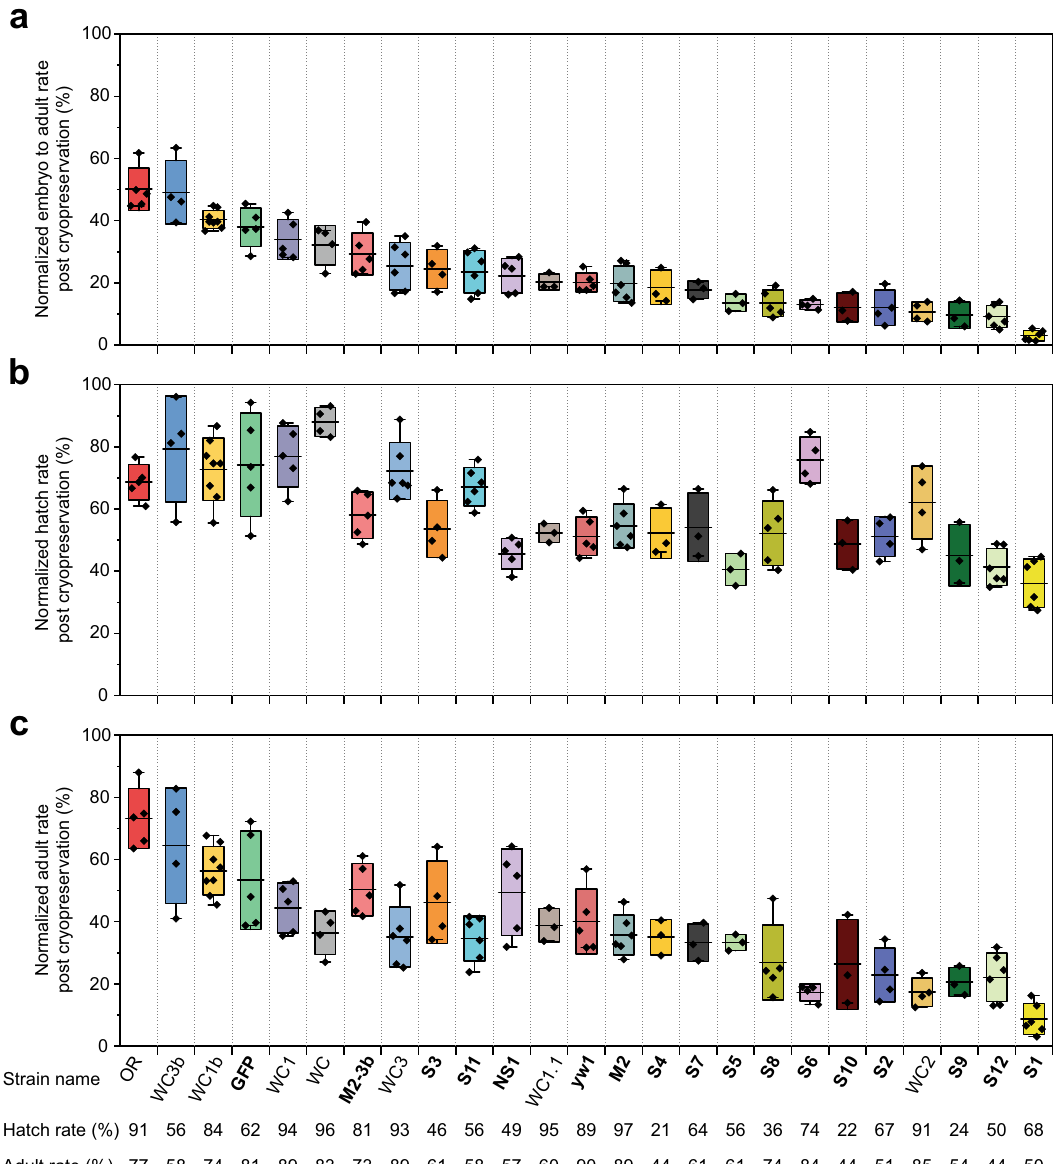
Fig. 4 Normalized post cryopreservation survival of 25 strains using the universal cryopreservation protocol. a Normalized embryo to adult rate of the 25 strains with different genotypes after cryopreservation. b Normalized hatch rate (embryos to larvae) and (c) adult rate (larvae, pupate, then enclose to adults) of the 25 strains after cryopreservation. The strain name is listed in ( c ). The hatch rate and adult rate of the control embryos (without treatment) are listed and used to normalize the post cryopreservation survival. In total, 17 mutant strains were included (strain name bolded). Strain GFP was obtained from the Bloomington Stock Center (stock # 30877). Strain S11 was obtained from the other Drosophila lab. n = 3 to 8 independent replicates for various strains. For strain OR, 1881 embryos were pooled over n = 5 independent replicates; for strain WC3b, 1267 embryos were pooled over n = 4 independent replicates; for strain WC1b, 2519 embryos were pooled over n = 8 independent replicates; for strain GFP, 1859 embryos were pooled over n = 5 independent replicates; for strain WC1, 1439 embryos were pooled over n = 5 independent replicates; for strain WC, 1874 embryos were pooled over n = 4 independent replicates; for strain M2-3b, 1612 embryos were pooled over n = 5 independent replicates; for strain WC3, 1741 embryos were pooled over n = 6 independent replicates; for strain S3, 1006 embryos were pooled over n = 4 independent replicates; for strain S11, 1500 embryos were pooled over n = 6 independent replicates; for strain NS1, 1478 embryos were pooled over n = 5 independent replicates; for strain WC1.1, 1183 embryos were pooled over n = 3 independent replicates; for strain yw1, 1971 embryos were pooled over n = 5 independent replicates; for strain M2, 1695 embryos were pooled over n = 6 independent replicates; for strain S4, 991 embryos were pooled over n = 3 independent replicates; for strain S7, 1077 embryos were pooled over n = 3 independent replicates; for strain S5, 1063 embryos were pooled over n = 3 independent replicates; for strain S8, 1564 embryos were pooled over n = 5 independent replicates; for strain S6, 1112 embryos were pooled over n = 4 independent replicates; for strain S10, 920 embryos were pooled over n = 3 independent replicates; for strain S2, 1119 embryos were pooled over n = 4 independent replicates; for strain WC2, 1664 embryos were pooled over n = 4 independent replicates; for strain S9, 960 embryos were pooled over n = 3 independent replicates; for strain S12, 1644 embryos were pooled over n = 6 independent replicates; for strain S1, 1817 embryos were pooled over n = 6 independent replicates. Box and horizontal line represent standard deviation and mean respectively; whiskers represent max and